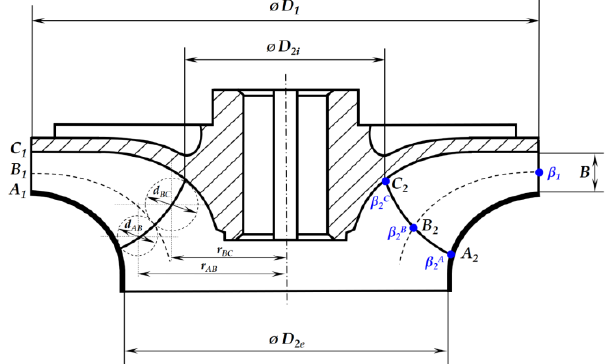
Figure 3. Meridional cross-section of the turbine impeller.